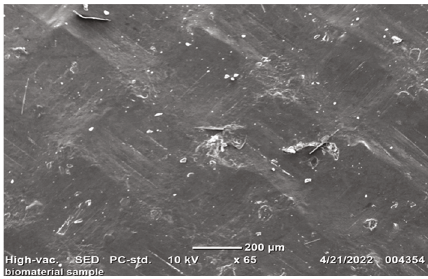
Figure 8: SEM analysis of SA-Ag-NP-incorporated chitosan